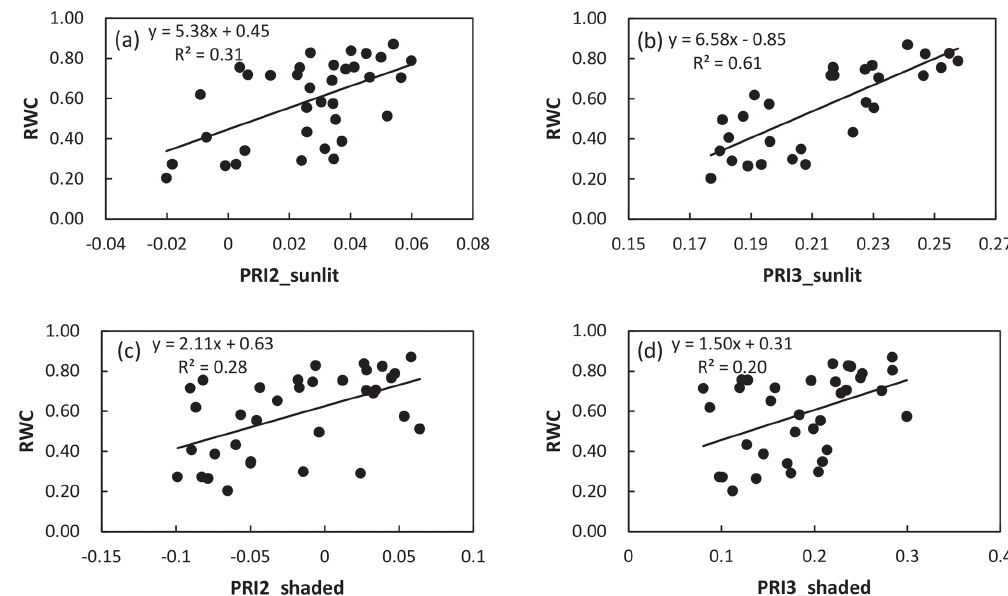
Figure 4. Examples of the linear relationship between PRI of sunlit leaves (PRI2, a ), PRI3, b ) and RWC, and the linear relationship between PRI of shaded leaves (PRI2, c , PRI3, d ) and RWC. Table 3. R 2 of the linear relationship between RWC and different formulations of PRI calculated by reflectance of varying the ratio of sunlit leaves to shaded leaves in winter wheat during the study period. RWC Shaded Shaded Shaded Shaded Shaded Shaded Shaded Shaded Shaded Shaded Shaded 0% 10% 20% 30% 40% 50% 60% 70% 80% 90% 100% sunlit sunlit sunlit sunlit sunlit sunlit sunlit sunlit sunlit sunlit sunlit 100% 90% 80% 70% 60% 50% 40% 30% 20% 10% 0% 0.12 ∗ 0.14 ∗ 0.33**